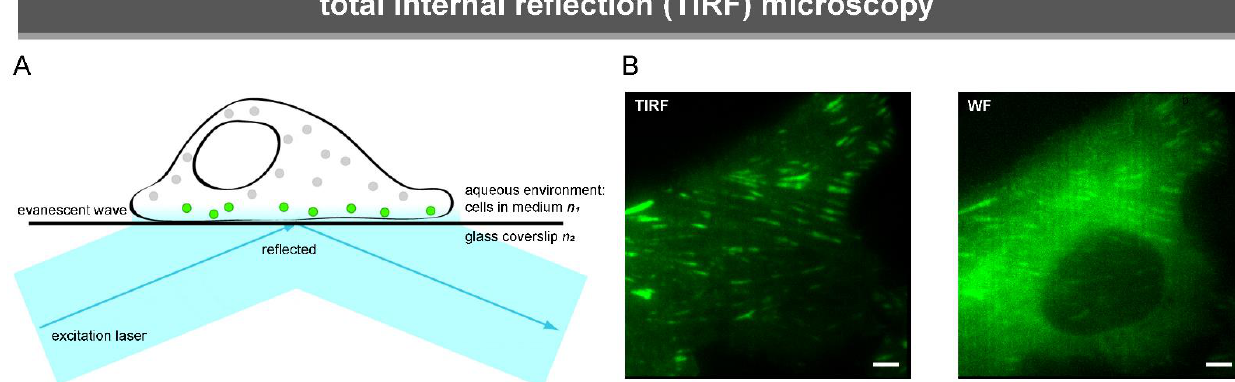
Figure 4. Total internal reflection microscopy. ( A ) Schematic overview of the light path during total internal reflection (TIRF) microscopy. The excitation laser exits the objective at such an angle that it is completely reflected at the glass – fluid interphase, formed by the glass coverslip and the aqueous environment of the cells in media, back into the objective. The reflecting laser light produces an electromagnetic field known as the evanescent wave, which exponentially declines. It is only powerful enough to excite fluorophores (green circles) in a thin layer ~100 – 200 nm upwards from the coverslip, leaving fluorophores at higher cellular locations unexcited (grey circles). ( B ) The same field of view, imaged in widefield (WF) or in TIRF mode, of a U2OS cell stably expressing paxillin-GFP. Scalebar 2 µm.